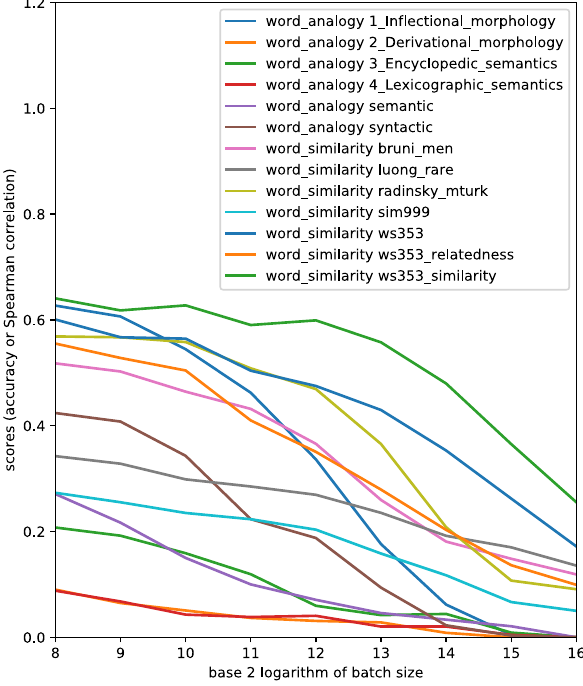
Fig. 13 The scores of word similarity task and word analogy task with different batch